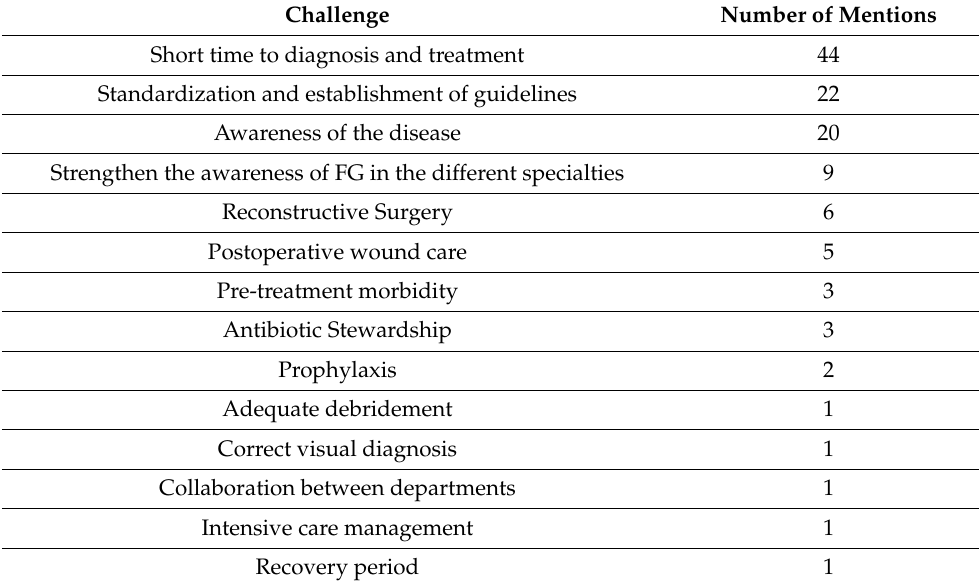
Table 1. Biggest challenges in FG and their importance to the survey